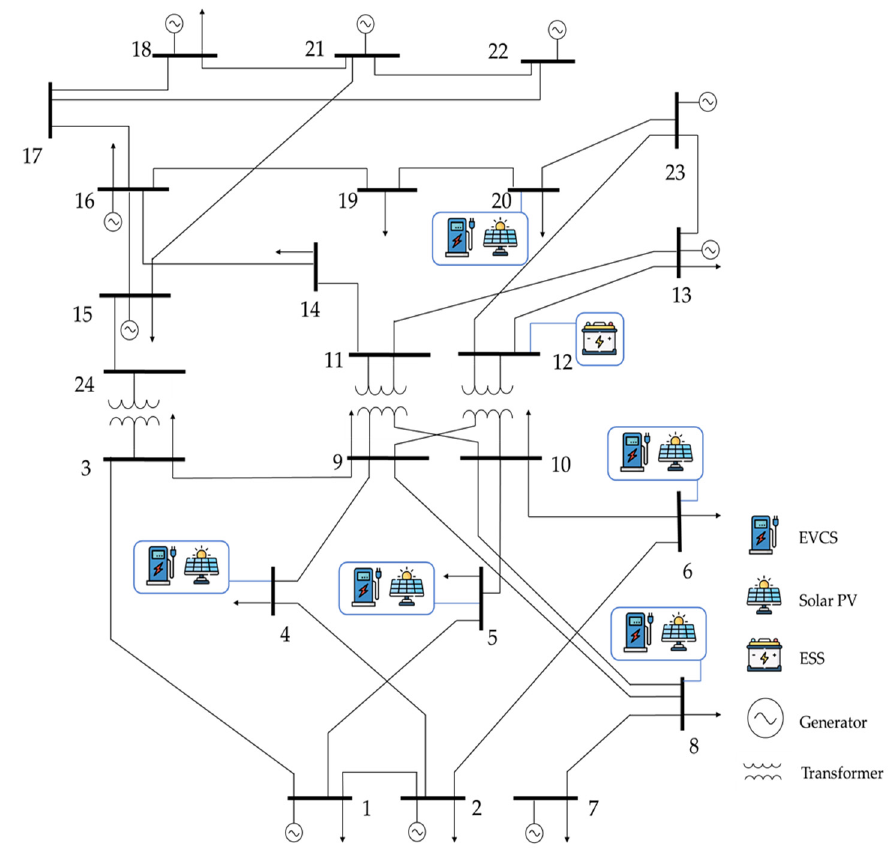
Figure 3. The RTS 24 with components of VPP.